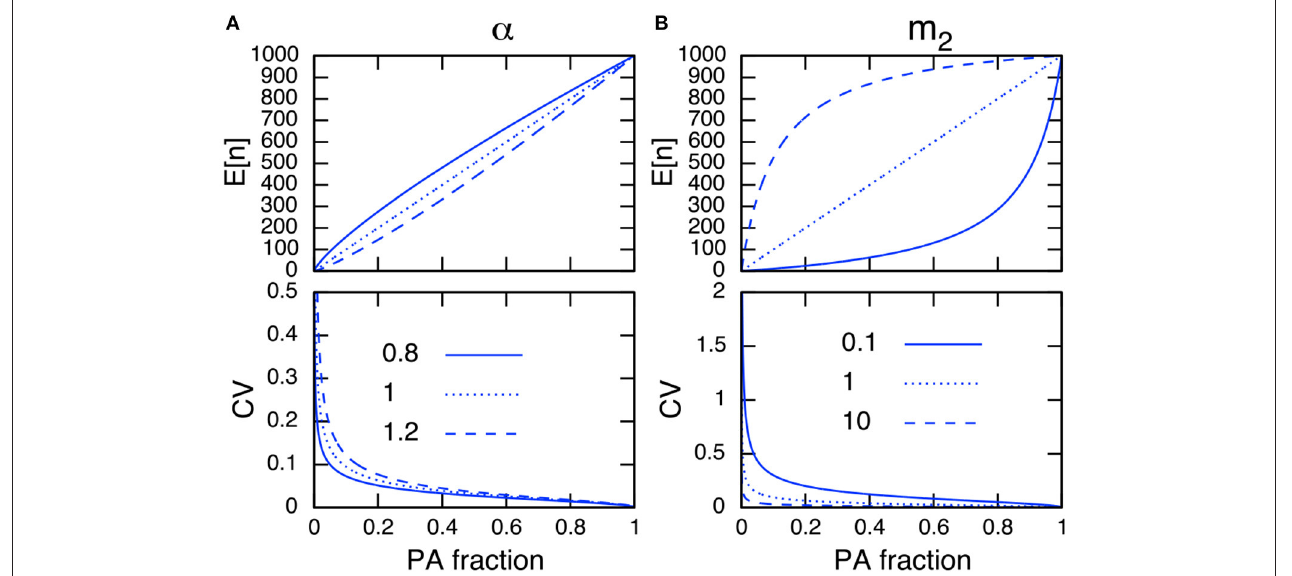
FIGURE 3 | Parameter dependence on E[ n ] (top) and the CV in PAs (bottom) of site preference α (A) and of immigration rate to PAs m 2 (B) . Other parameter values used are N = 1,000, m 1 = 1 (A) , and α = 1 (B) . Note the site preference is α < 1 when PAs are preferred and α > 1 when non-PAs are preferred.